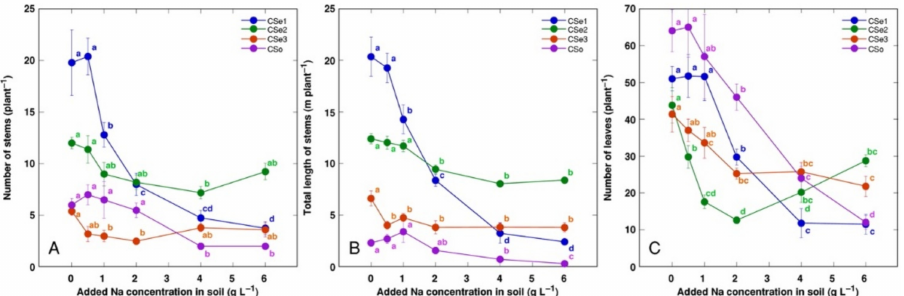
Figure 3. Effect of increasing soil salinity on the number of stems ( A ), total stem length ( B ), and number of leaves ( C ) of Calystegia sepium accessions CSe1, CSe2, CSe3 and Calystegia soldanella (CSo). Na + was added in a form of NaCl. Data are means from five replicates for each concentration ± SE. Different letters of the respective color indicate statistically significant differences ( p < 0.05) between treatments for the respective model plant.